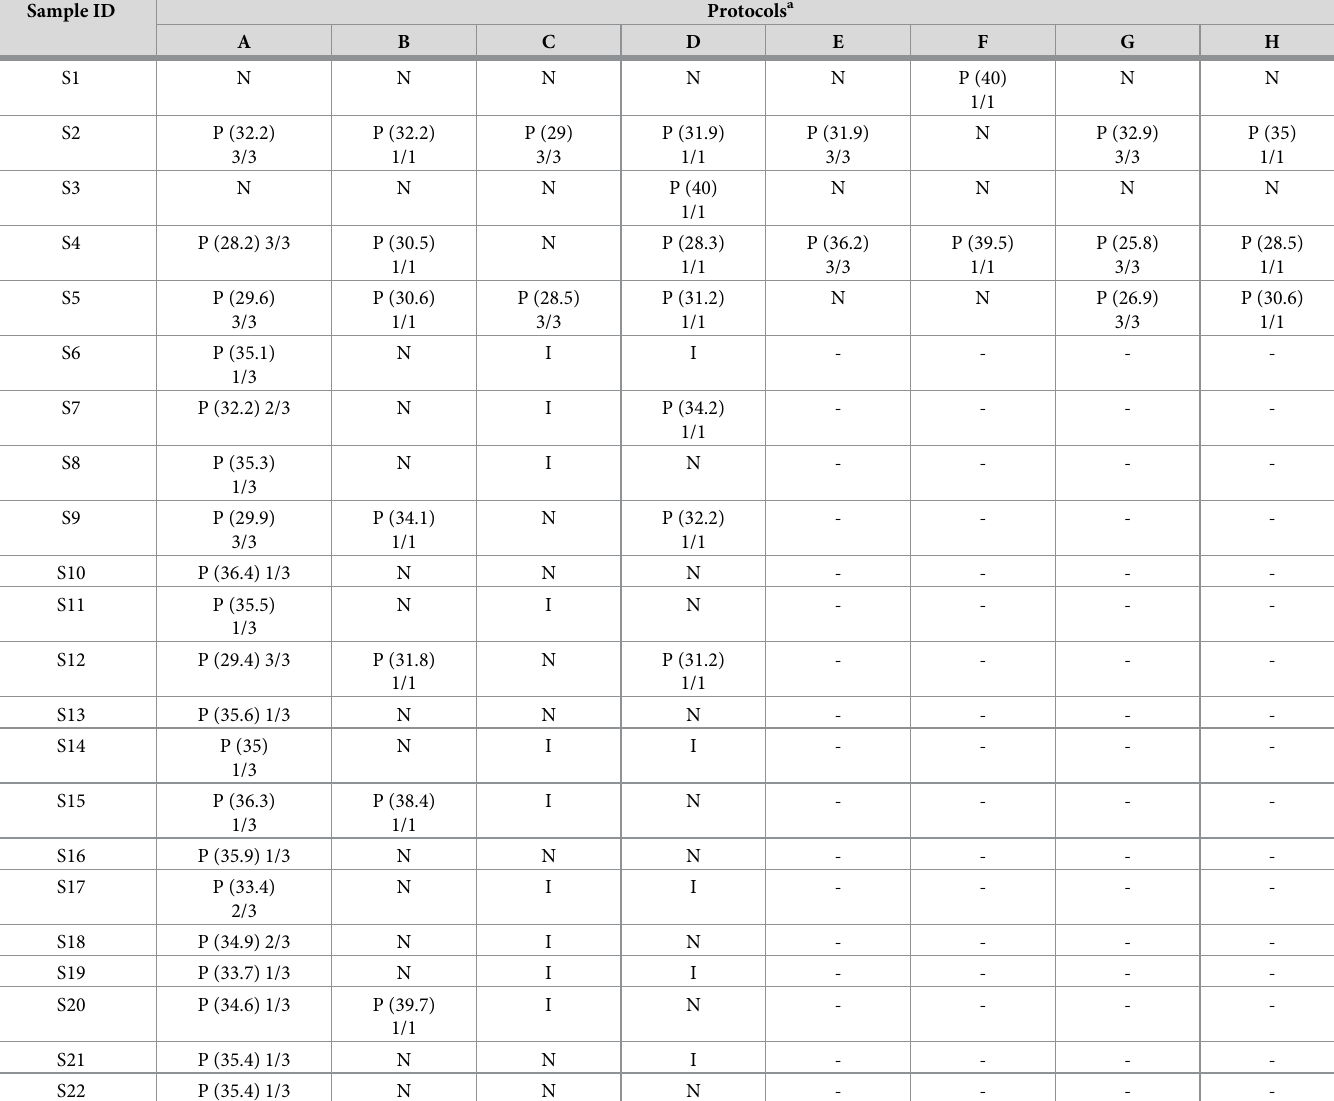
Table 3. Trypanosoma cruzi diagnostic Real-Time PCR results obtained in the eight protocols assessed for the 22 discordant samples. Sample